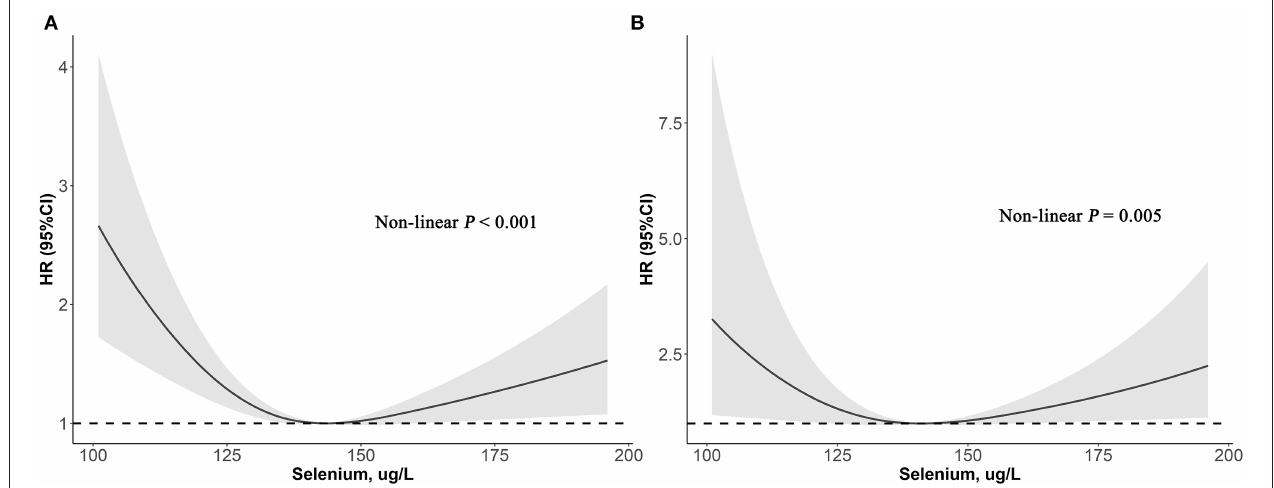
FIGURE 2 | Association of selenium levels with the all-cause (A) and cardiovascular mortality (B) performed by restricted cubic spline analysis.